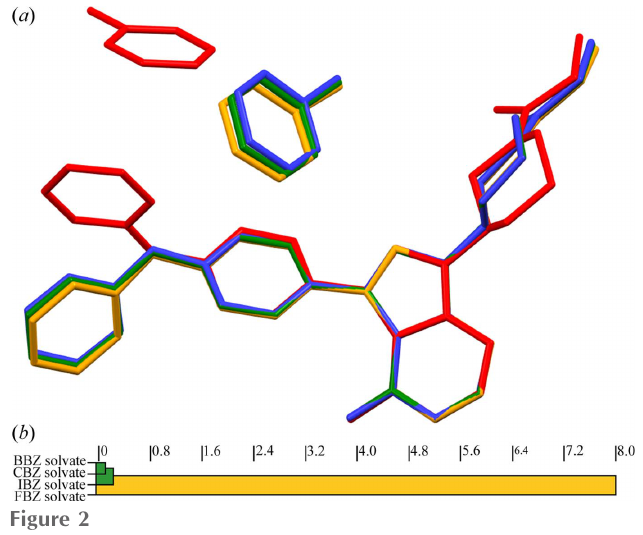
Figure 2 ( a ) Comparison of the solvate crystal structures (red – FBZ solvate, green – CBZ solvate, blue – BBZ solvate, orange – IBZ solvate). ( b ) Packing similarity dendrogram generated by CrystalCMP